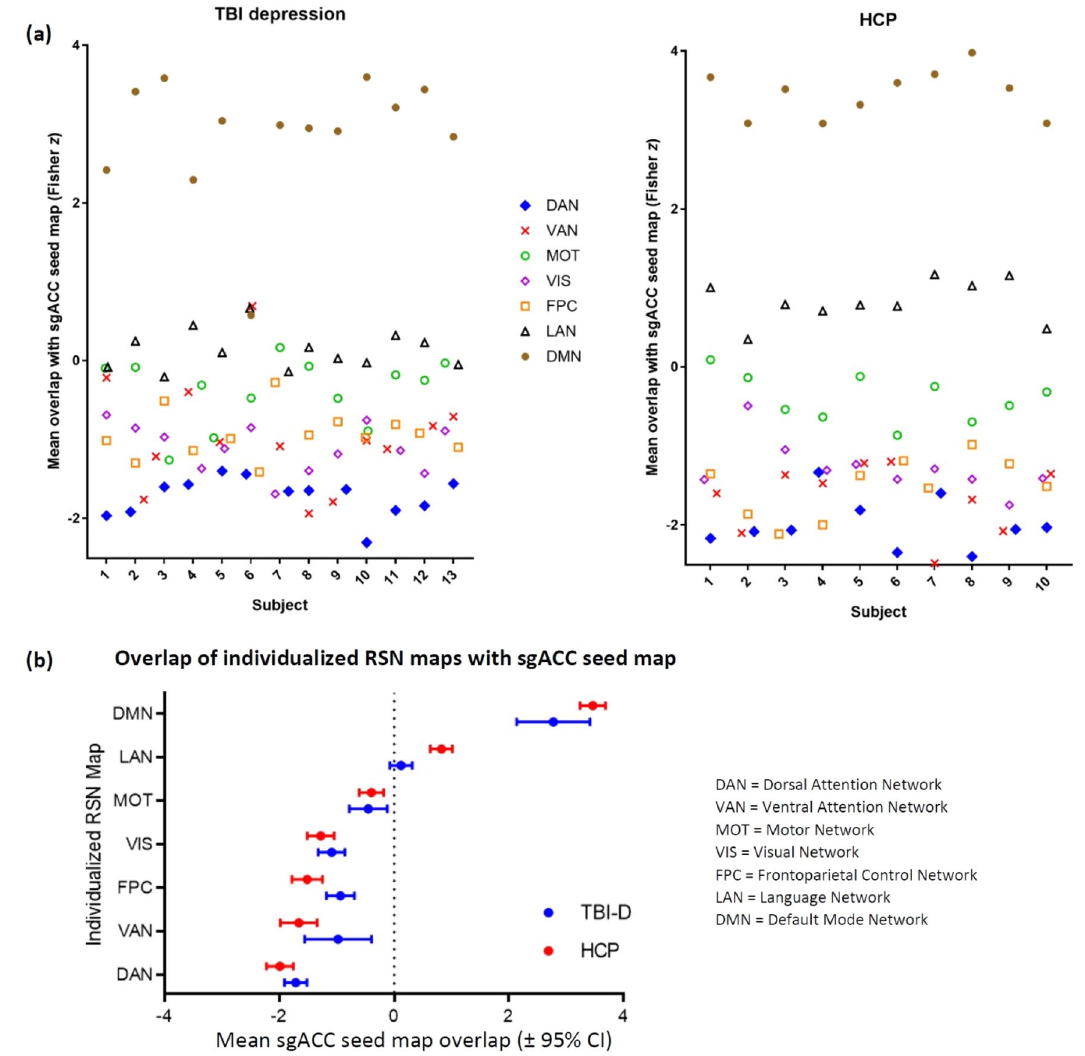
Figure 2. ( a ) Individualized similarity between each RSN and the normative sgACC seed map at baseline. The group-mean sgACC seed map positive correlations overlapped more with DMN and the anti-correlations overlapped more with DAN than any other individualized RSN map for the majority of individual subjects. ( b ) Mean similarity between individualized RSNs and the normative sgACC seed map. DMN was the only network showing strong overlap with the positive correlations in the sgACC seed map. Several RSNs showed notable overlap with the anti-correlations in the sgACC seed